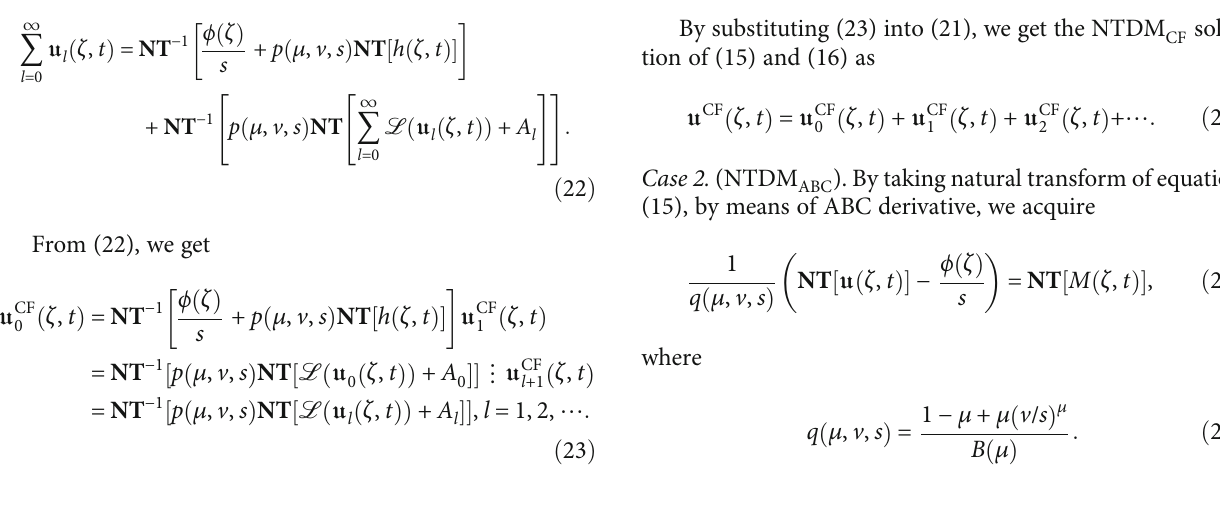
for μ = 0 : 75 , (c) NTDM CF